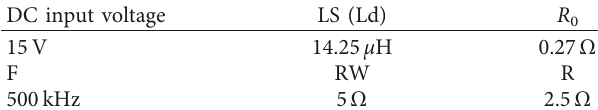
Table 2: System parameters.